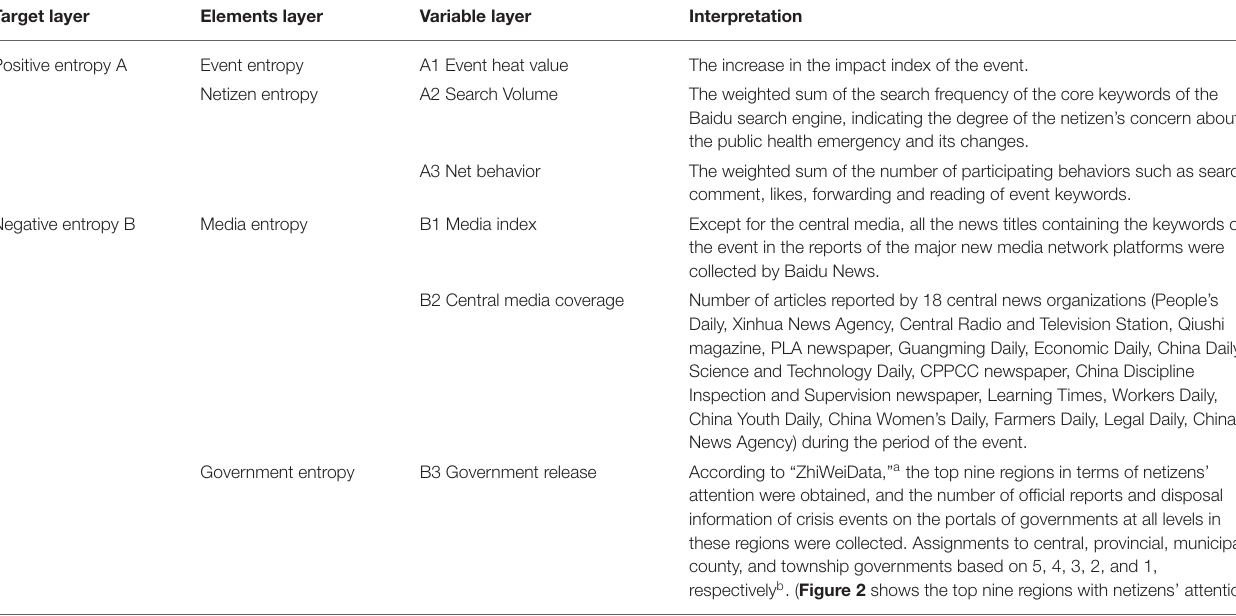
TABLE 1 | Positive and negative entropy index system of internet public opinion